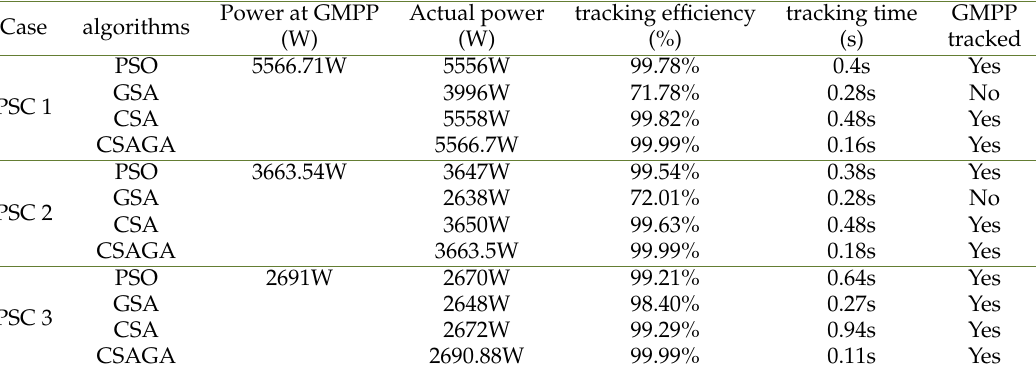
Table 3. Comparison of simulation results of four MPPT algorithms.